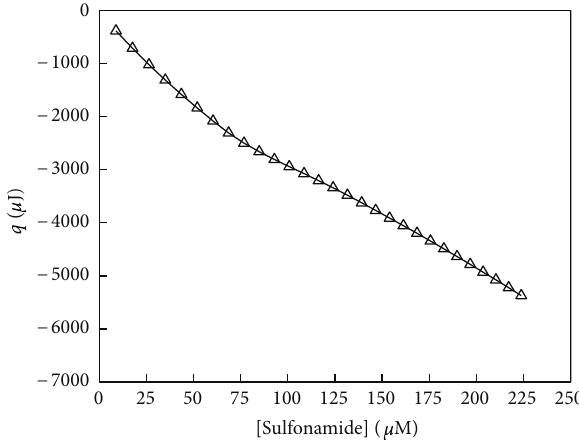
T 2: Binding parameters for HAS + nanosulfonamide interac- tions. e interaction is both enthalpy and entropy driven indicating that the electrostatic interactions are dominant.